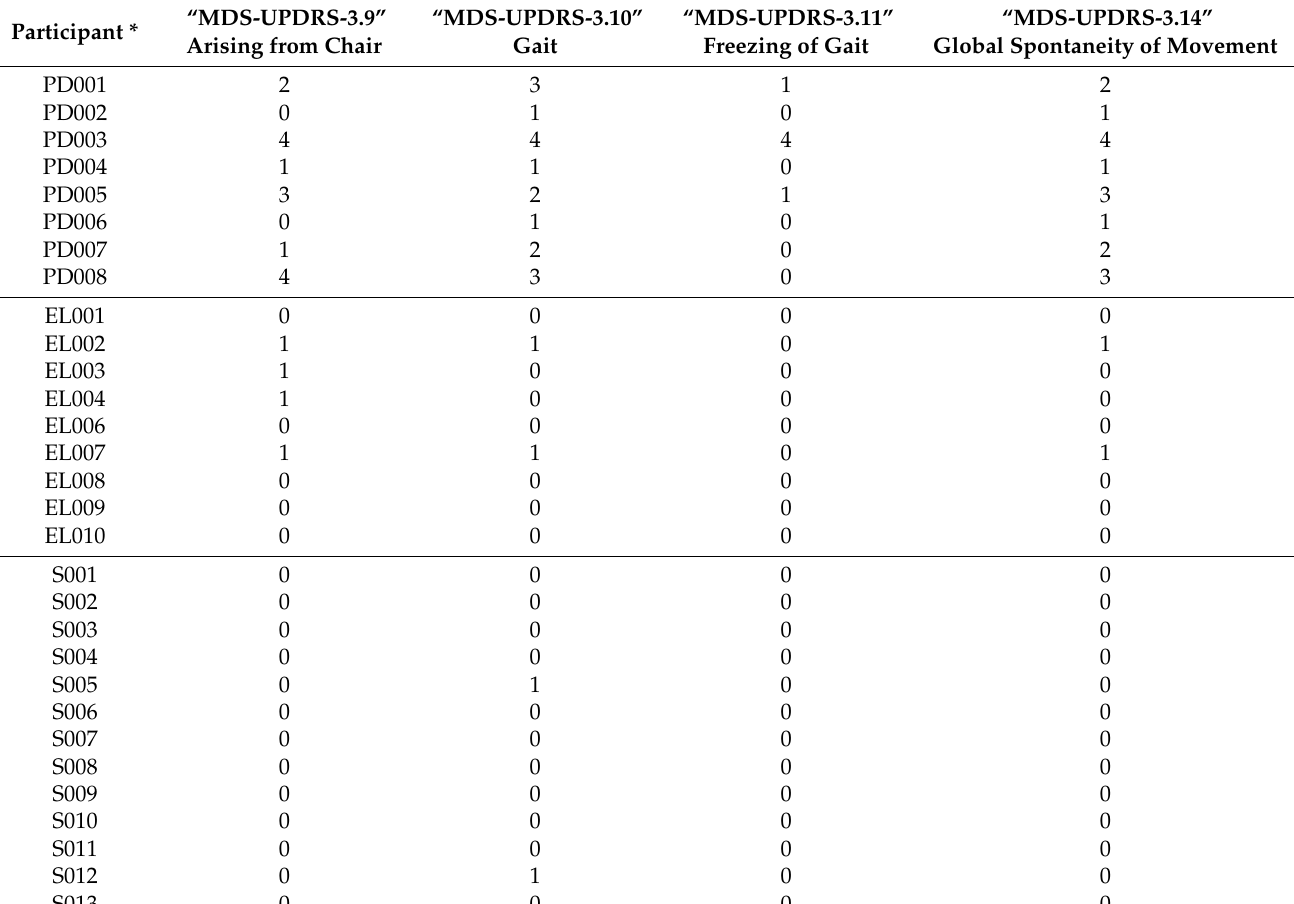
Table 2. The rating of four MDS-UPDRS items [29], based on the analysis of participant’s videos. Participant